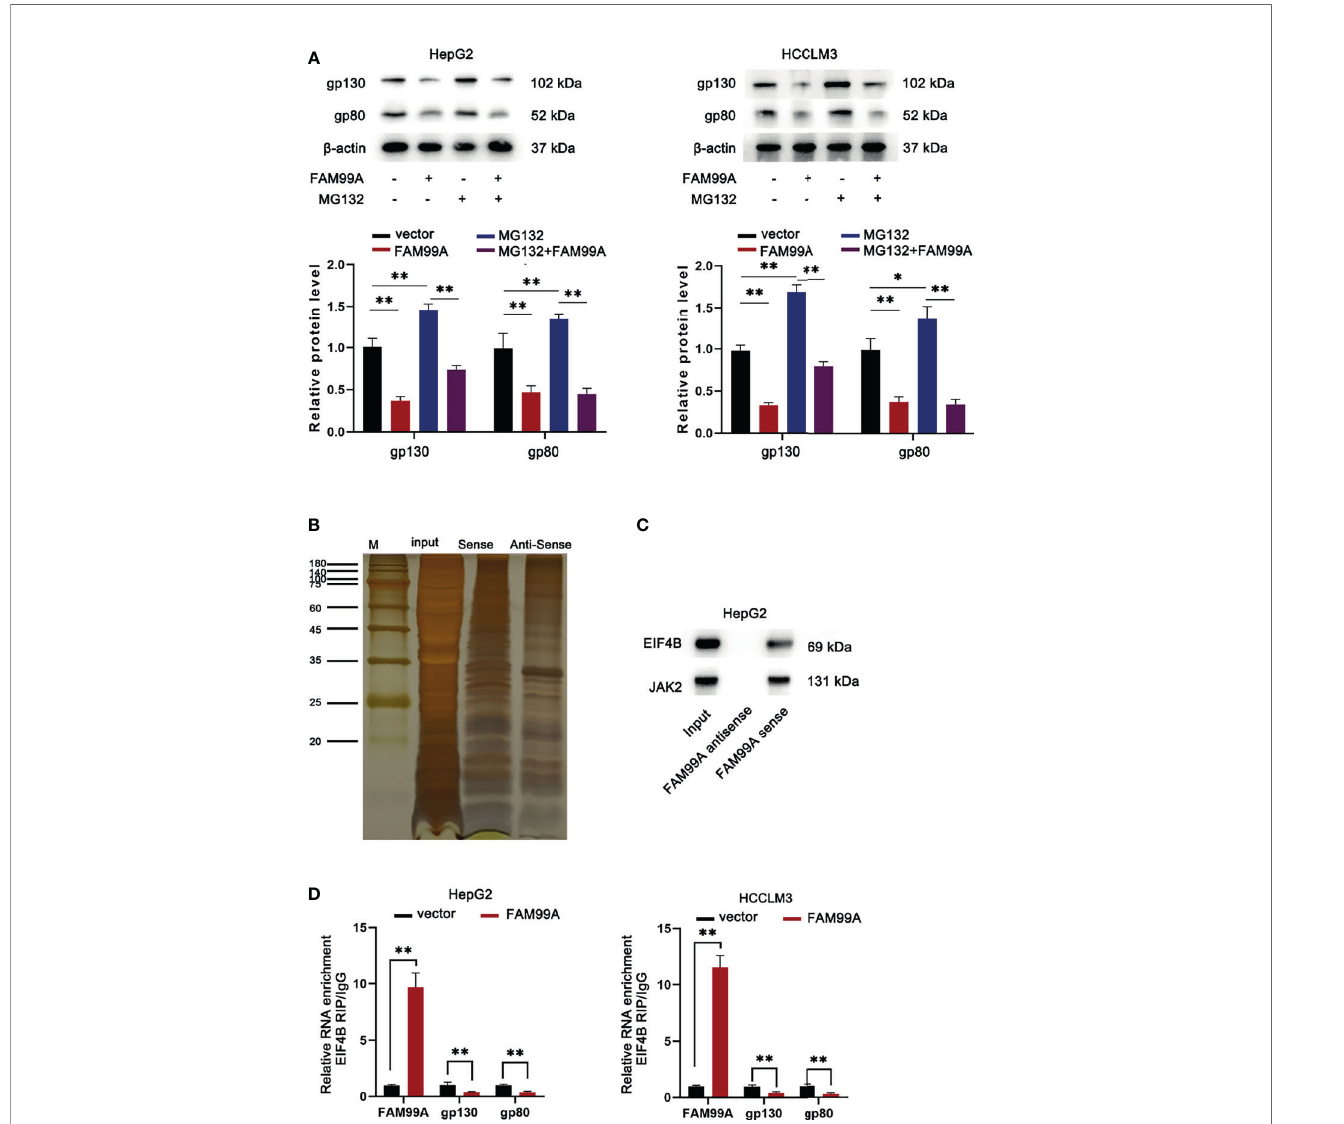
FIGURE 5 | FAM99A blocked the translation of gp130 and gp80 via binding to EIF4B. (A) Western blotting assay was used to detect the protein levels of gp130 and gp80 in HCC cells after the transfection of pcDNA3.1/FAM99A and treatment of MG132. (B) Silver staining and differential band mass spectrometry assays were conducted to analyze the binding protein pulled down by FAM99A. (C) Western blotting veri fi ed the presence of EIF4B and JAK2 in the products pulled down by biotinylated FAM99A. (D) RIP and qRT-PCR assays were conducted to detect the enrichment of FAM99A, gp130, and gp80 in EIF4B precipitates in HepG2 cells. * P < 0.05, ** p <